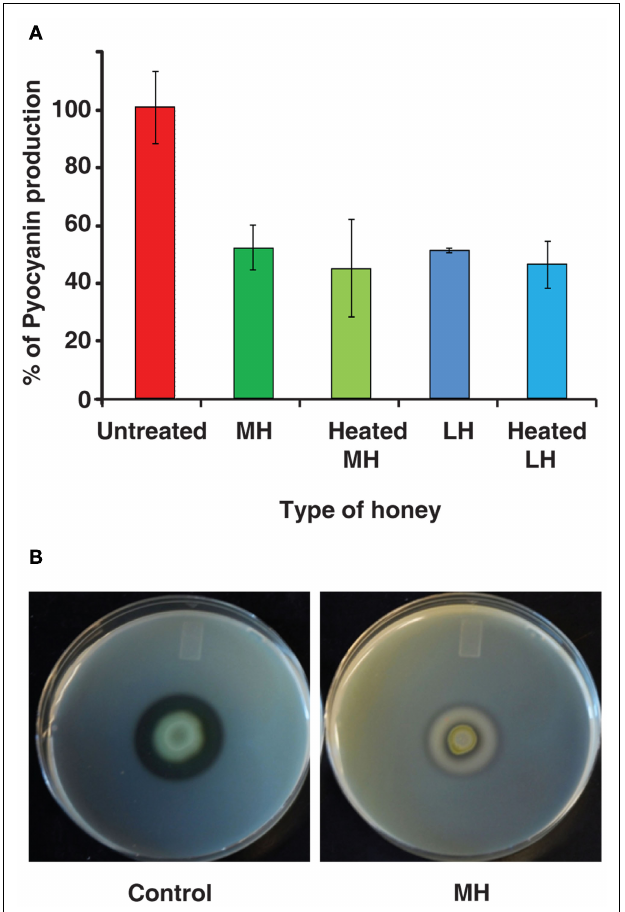
FIGURE 2 | Honey impacts production of virulence factors. (A) Indicates honey decreases the production of pyocyanin, a virulence factor regulated by the MvfR QS network of P. aeruginosa . Pyocyanin is displayed as a percentage normalized to the control (no honey added). (B) demonstrates the effect on extracellular protease production by honey. Milk plates were inoculated with 2 μ L of bacterial culture and incubated for 48h at